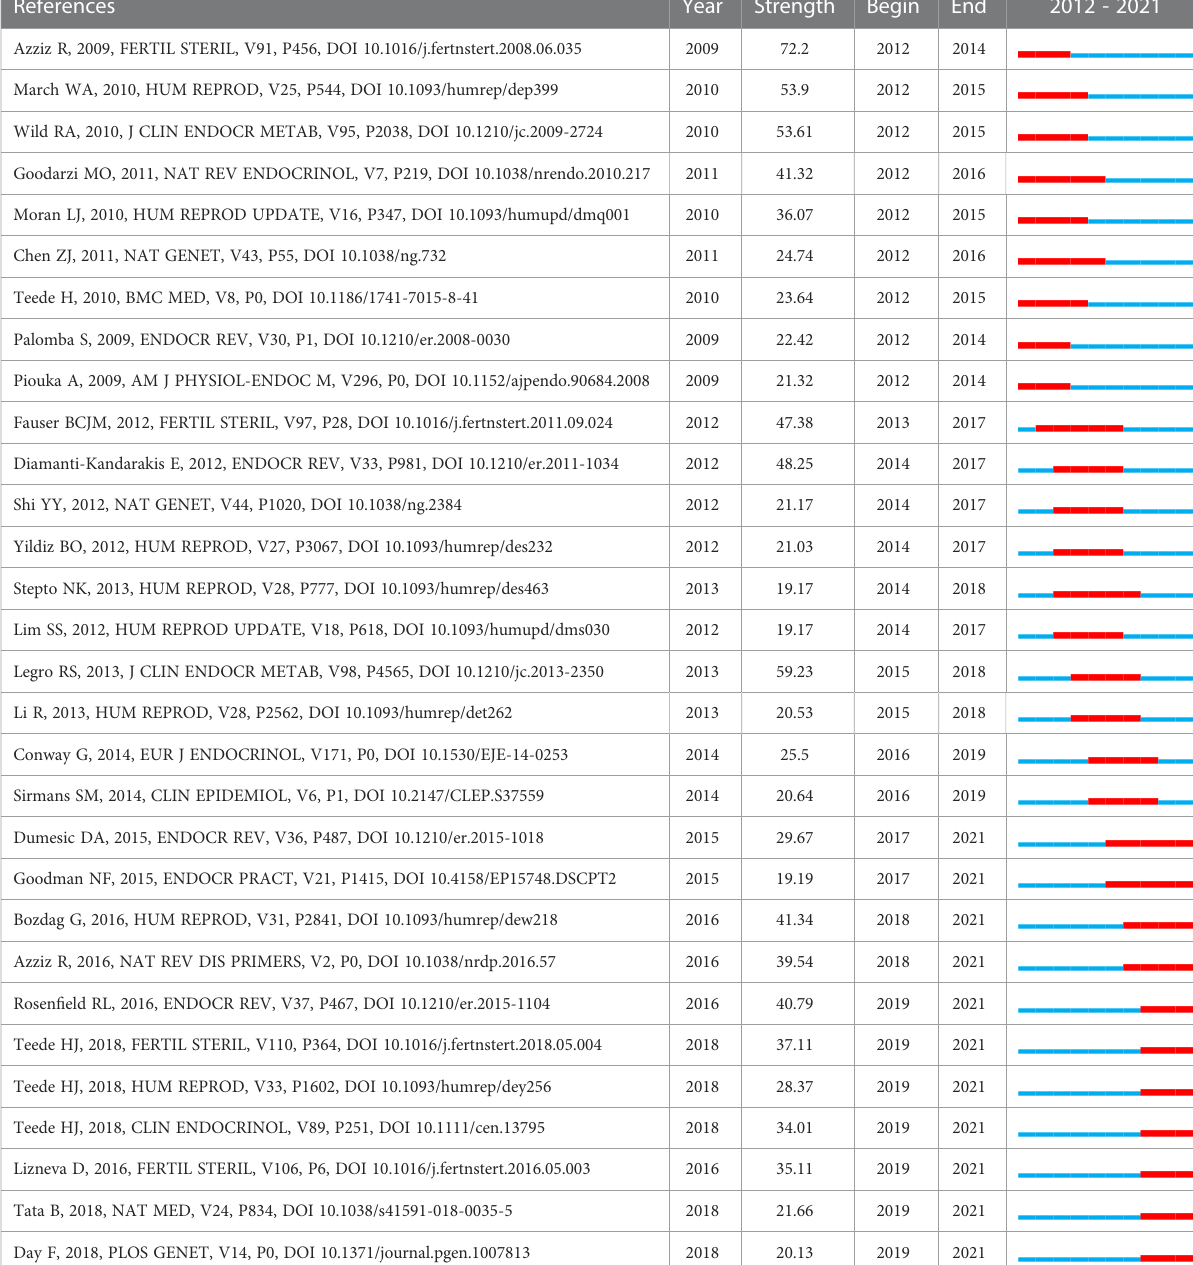
TABLE 2 The top 30 references co-citation with the strongest citation